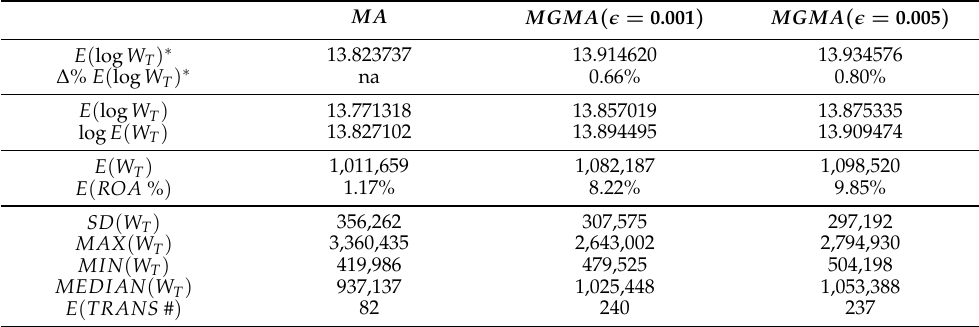
Table 7. MGMA strategy performance summary for scenario 2 on simulated three-asset portfolio (1000 run; s = 5; l = 10). MA MGMA ( (cid:101) = 0.001